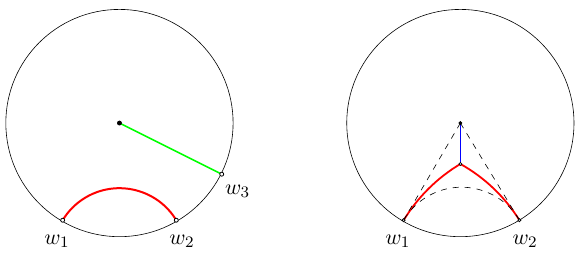
Figure 5 . N=4 tree with four points on the boundary.